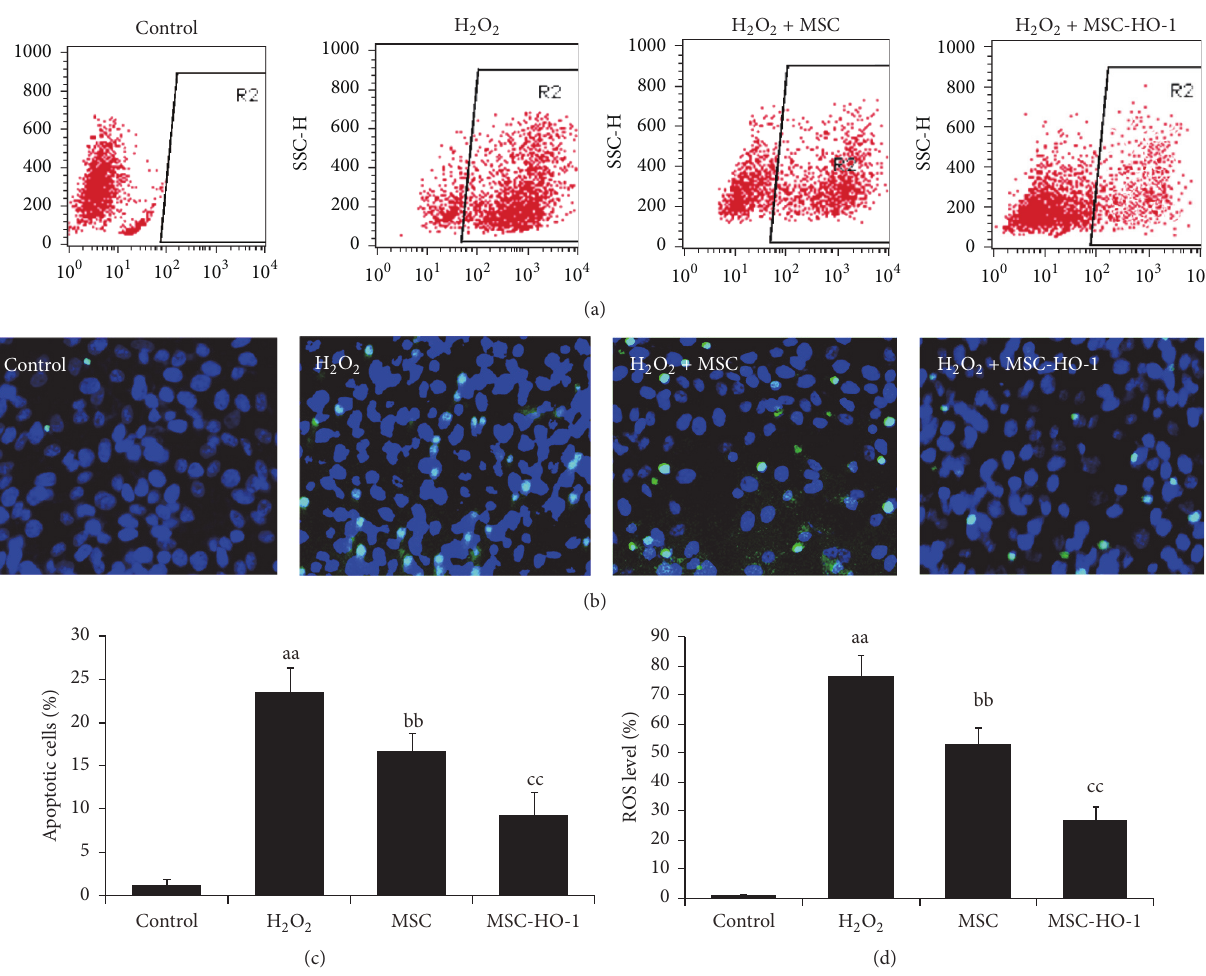
Figure 2: The effects of HO-1 overexpression in MSC on intracellular ROS levels and apoptosis. MSC or MSC-HO-1 were indirectly cocultivated with RGC-5 after adding H 2 O 2 . (a) Intracellular ROS levels in RGC-5 were analyzed by flow cytometry. (b) Representative TUNEL images of RGC-5. (c) and (d) The quantitative detection of ROS levels and apoptosis of RGC-5 ( 𝑛 = 5 ). aa 𝑃 < 0.01 compared with control; bb 𝑃 < 0.01 compared with H 2 O 2 group; cc 𝑃 < 0.01 compared with MSC